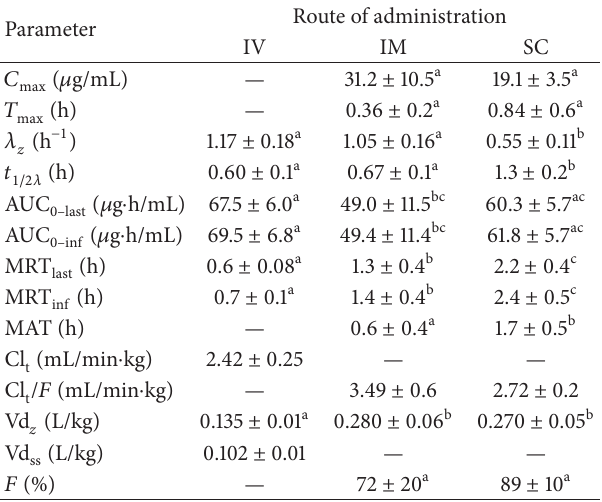
a.b.c Values within a row with different superscripts indicate significant differences ( 𝑝 < 0.05 ). 𝐶 max : peak serum concentration; 𝑇 max : time toreach peak serum concentra- tion; 𝜆 : apparent terminal rate constant; 𝑡 1/2 𝜆 : terminal half-life; AUC 0 – last : area under the serum concentration-time curve from time zero to last point; AUC 0 – ∞ : area under the serum concentration-time curve from time zero to infinity; MRT: mean residence time; MAT: mean absorption time; Cl t : total body clearance; Vd 𝑧 : apparent volume of distribution; Vd ss : volume of distribution at the steady state; 𝐹 : absolute